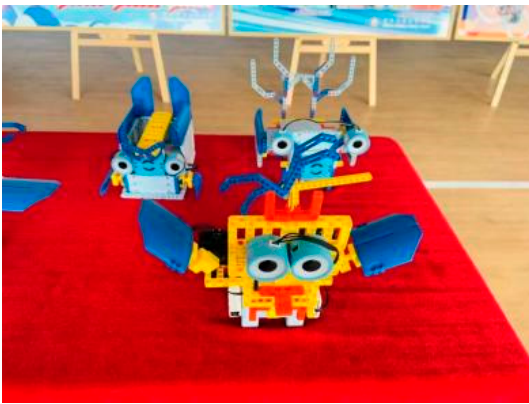
Figure 1. uKit Explore home page interface.